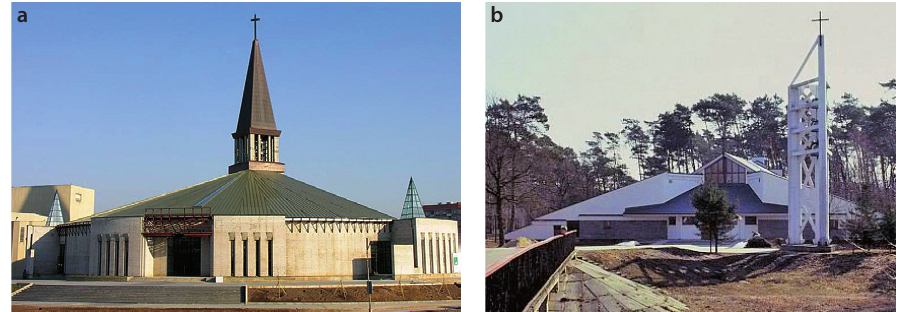
Fig. 9. Churches of Simplistic model: a – Church in Mažeikiai (archit.: H. Štaudė, R. Kazlauskas, 2005), b – Church of Lithuanian Martyrs in Berčiūnai (archit. A. Šironas,